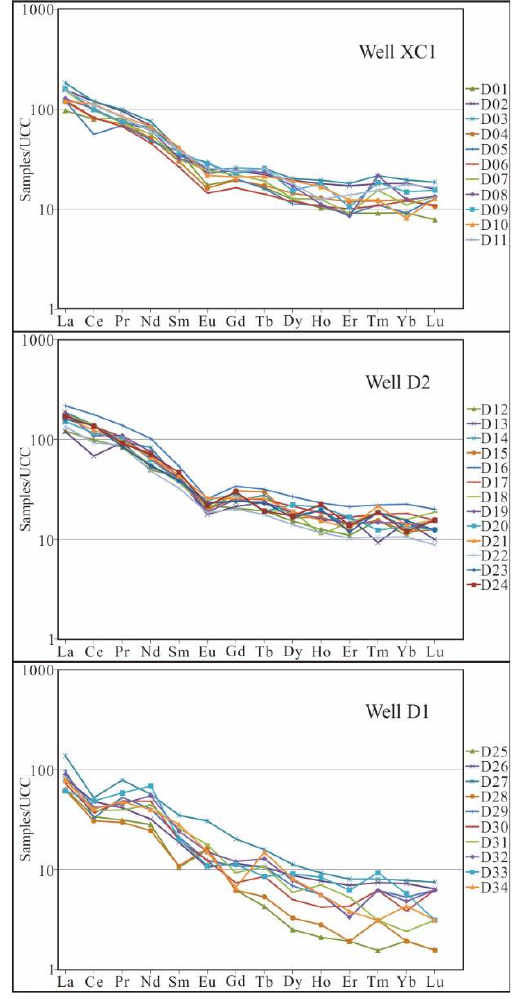
Figure 6. UCC − normalized rare earth element spidergrams of the samples.